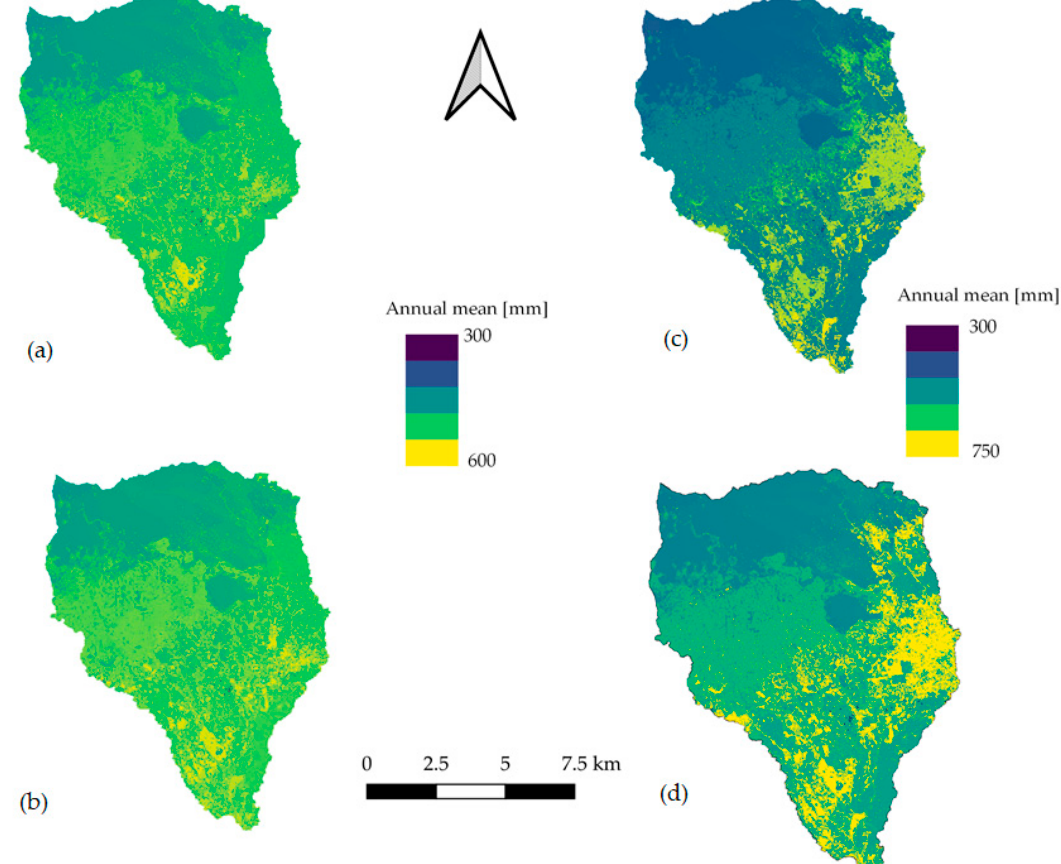
Figure 4. ( a ) ET at HRU level in default SWAT model; ( b ) ET at HRU level in default SWAT + model; ( c ) ET at HRU level after implementation of trajectories in the SWAT model; ( d ) ET at HRU level after implementation of trajectories in SWAT +